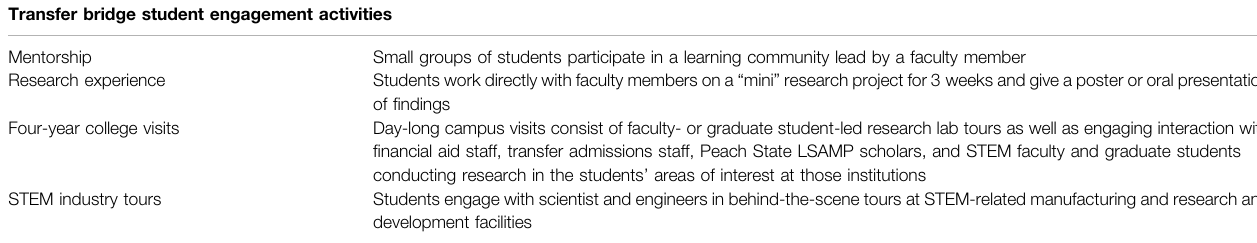
TABLE 1 | Transfer bridge high impact student